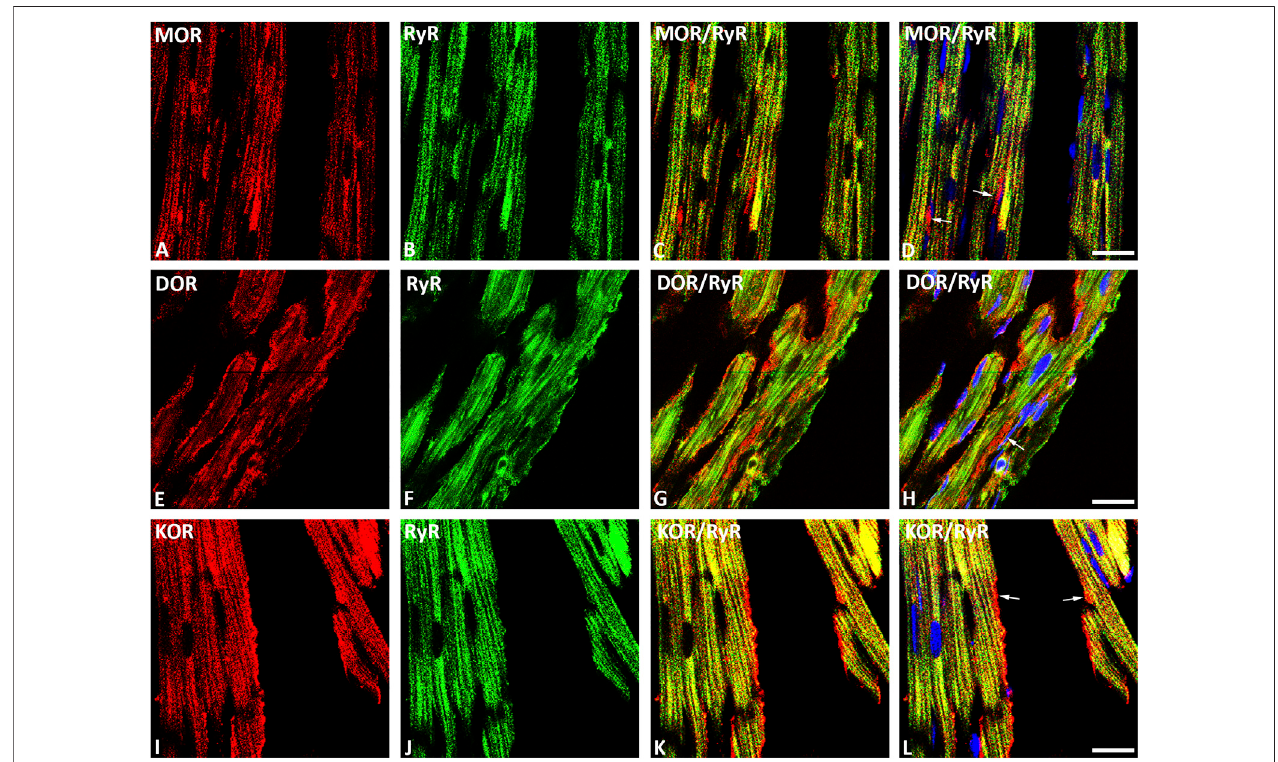
FIGURE 2 | Double immuno fl uorescence confocal microscopy of opioid receptor subtypes mu (MOR) (A) , delta (DOR) (E) , and kappa (KOR) (I) (Texas red immuno fl uorescence)incombinationwiththesarcoplasmaticryanodinereceptor(RyR)(FITCgreen fl uorescence) (B , F , J) inratleftventricularmyocardium. (C – L) show co-expression of opioid receptor subtypes MOR, DOR and KOR with RyR on the cardiomyocytes of the rat left ventricle (yellow fl uorescence). Note that rows of mitochondria are located between cardiomyocytes and are immunostained for MOR (D) , DOR (H) or KOR (L) as indicated by the red fl uorescence (arrow). Nuclei are indicated by their bright blue fl uorescence (D , H , L) . Bar = 10 μ m.